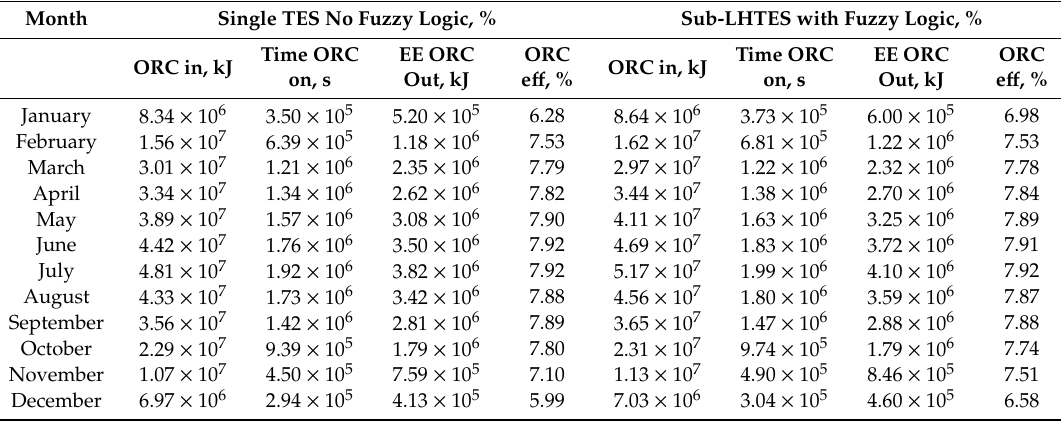
Figure 12. Relative variation of the TES thermal performance parameters between the configuration with and without fuzzy logic. Table 3. Monthly performance of the ORC unit in the presence of single TES or subdivided